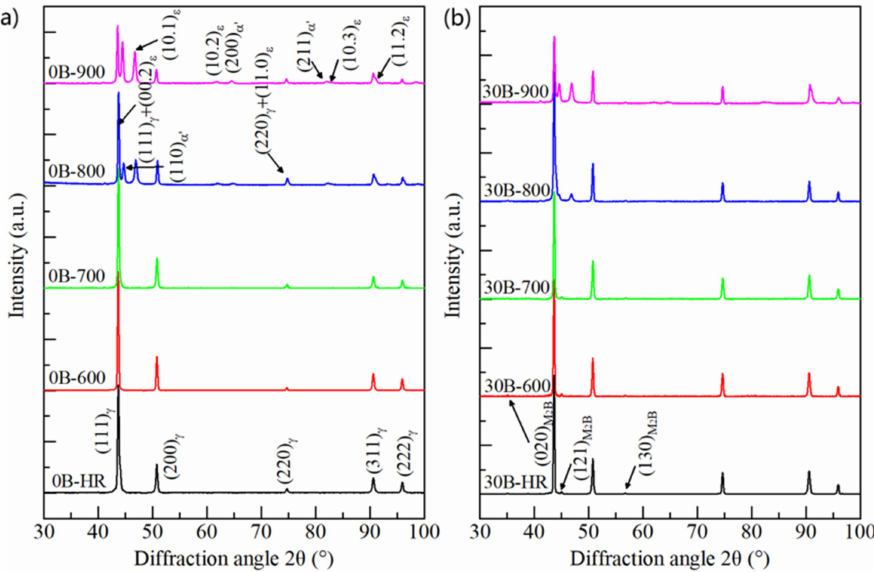
Figure 3. XRD patterns of the hot-rolled and annealed samples. ( a ) 0B steel; ( b ) 30B